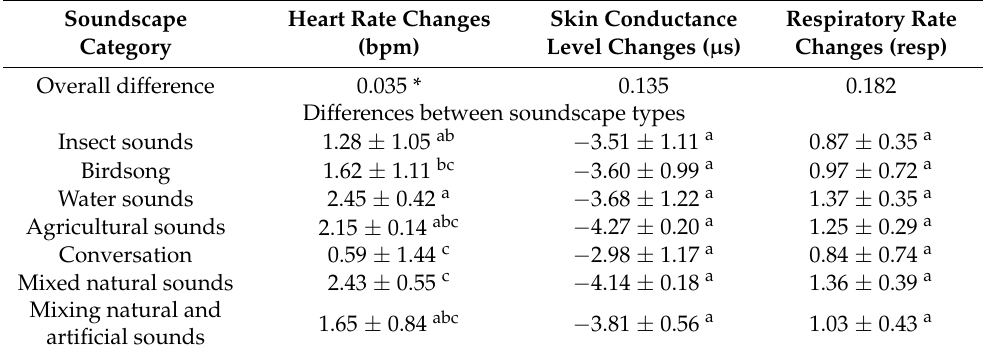
Table 3. A comparison of the physiological indices of the subjects for different